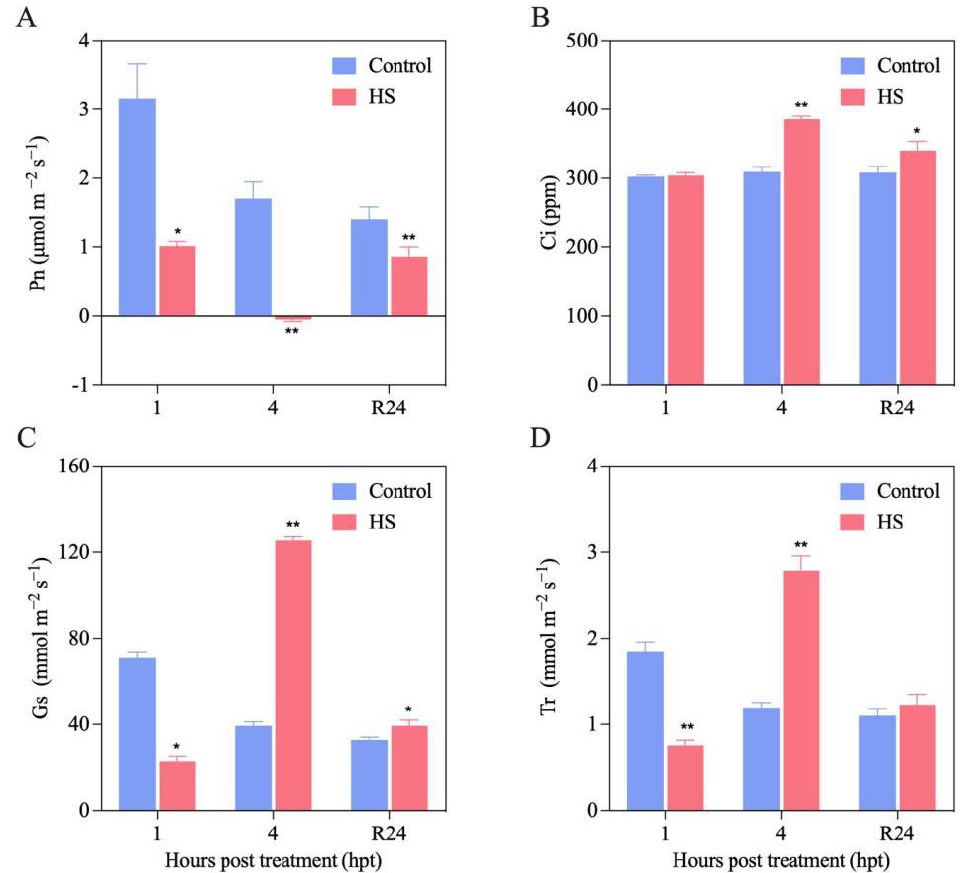
Figure 3. Effect of HS treatment on gas exchange parameters. ( A ) net photosynthetic rate (Pn), ( B ) intercellular CO 2 concentration (Ci), ( C ) stomatal conductance (Gs), ( D ) transpiration rate (Tr). Gas exchange parameters were measured on the fifth leaf from the top of each plant at a CO 2 concentration of 400 µ mol mol − 1 and a PPFD of 1200 µ mol m − 2 s − 1 . Asterisks indicate statistical significance (* 0.01 < p < 0.05, ** p < 0.01, Student’s t -test) of differences between the HS treatment and control at three sampling time-points. Data represent mean values ± SD from three independent experiments.